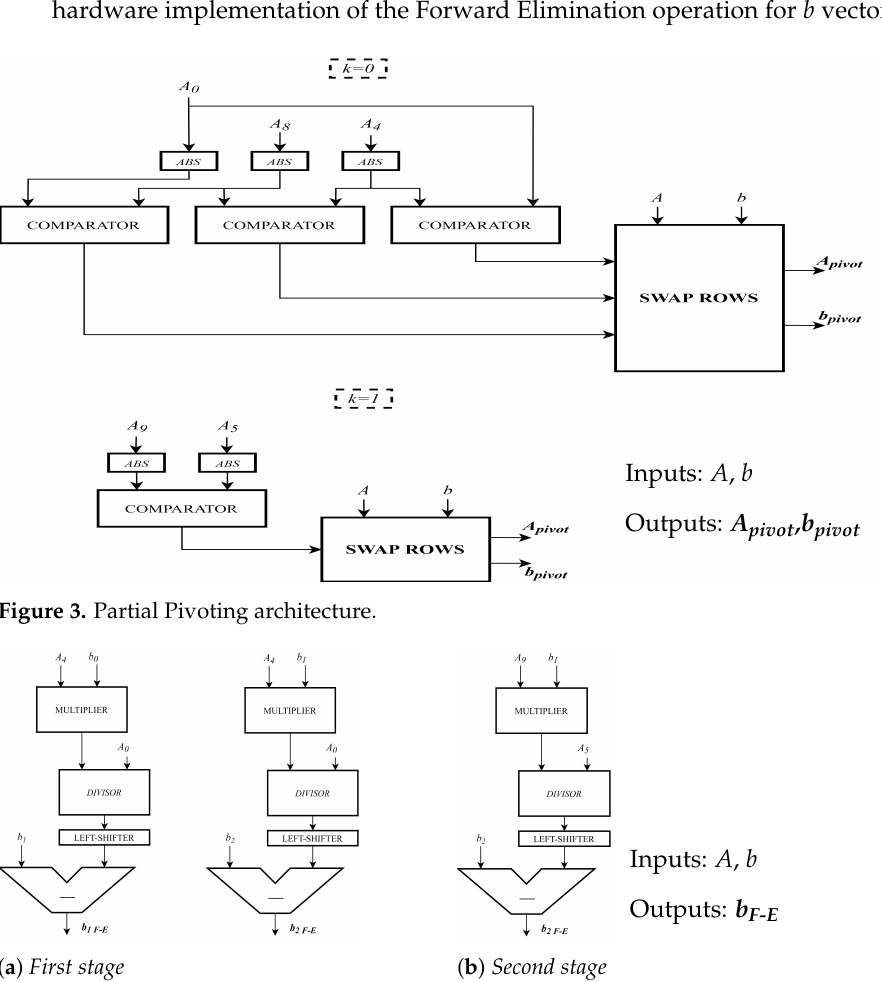
Figure 4. Forward Elimination